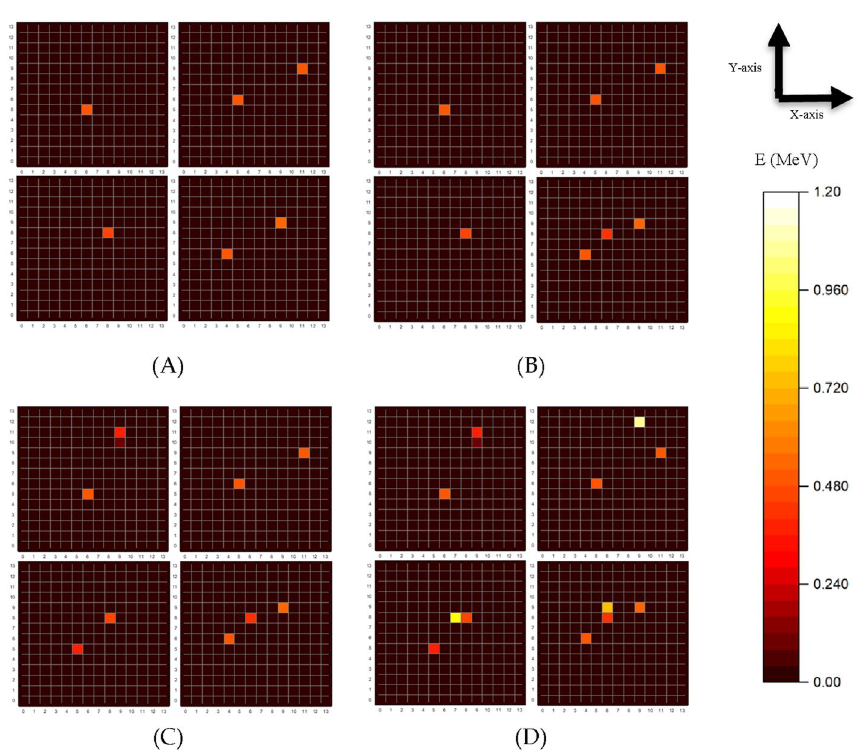
Figure 1. The γ energy distribution of a top view of the BGO scintillators. An example of four randomly selected events are compared for the four different energy cutoff ranges given in Table 1: ( A ) 1σ, ( B ) 2σ, ( C ) above 2σ, and ( D ) no